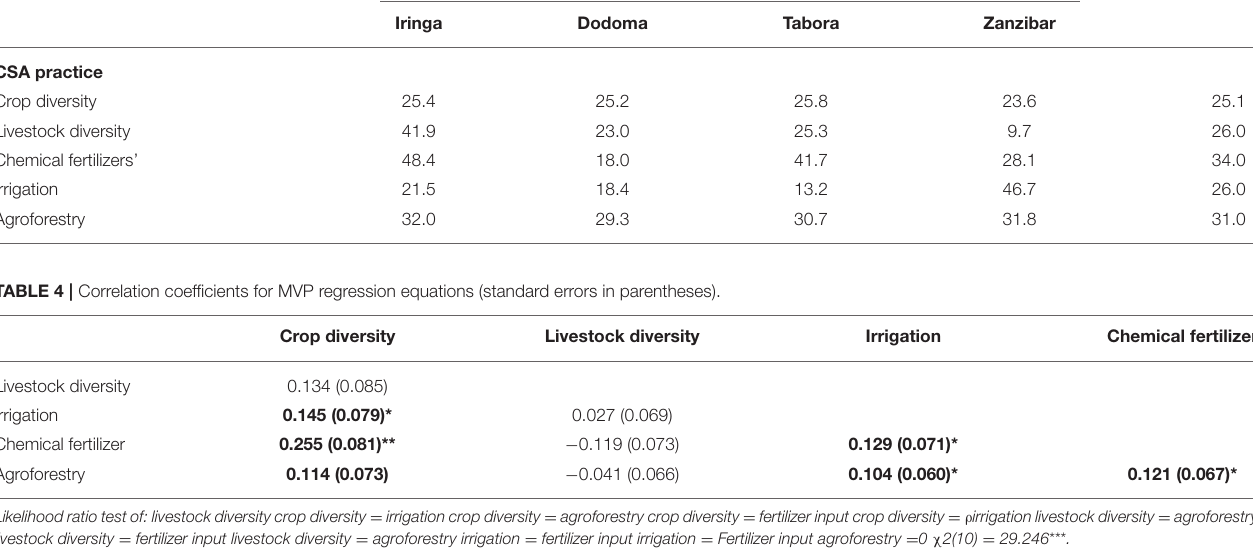
TABLE 3 | Adoption levels of CSA technologies and practices per each location and the overall rate (%). CSA technologies and practices